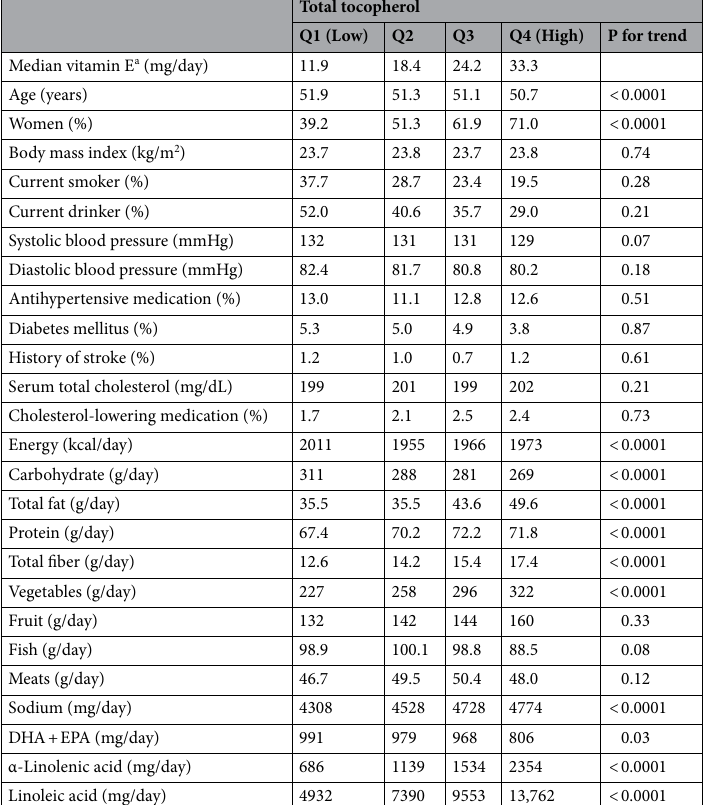
Table 1. Characteristics of participants aged 40–64 years, according to quartiles of total tocopherol intake at dietary surveys, CIRCS 1985–1999. a Energy-adjusted values by nutrient residual